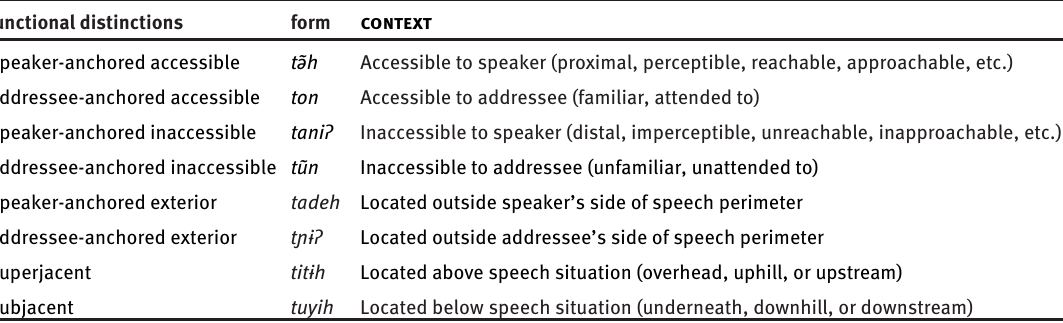
Table 6: Jahai demonstratives (Burenhult 2003, Evans et al. 2018a) functional distinctions